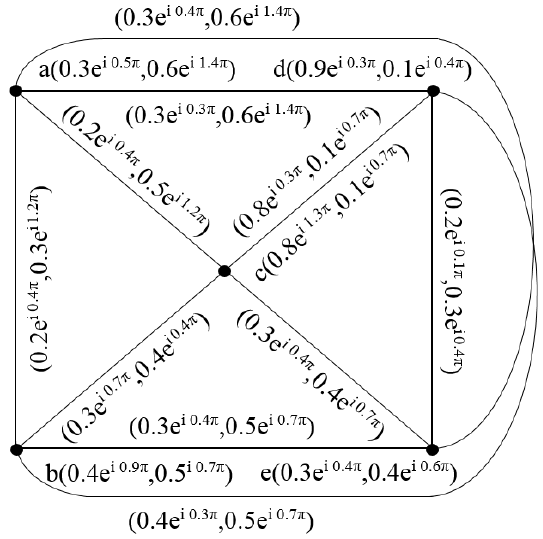
Figure 10. Complex intuitionistic fuzzy graph of G 1 + G 2